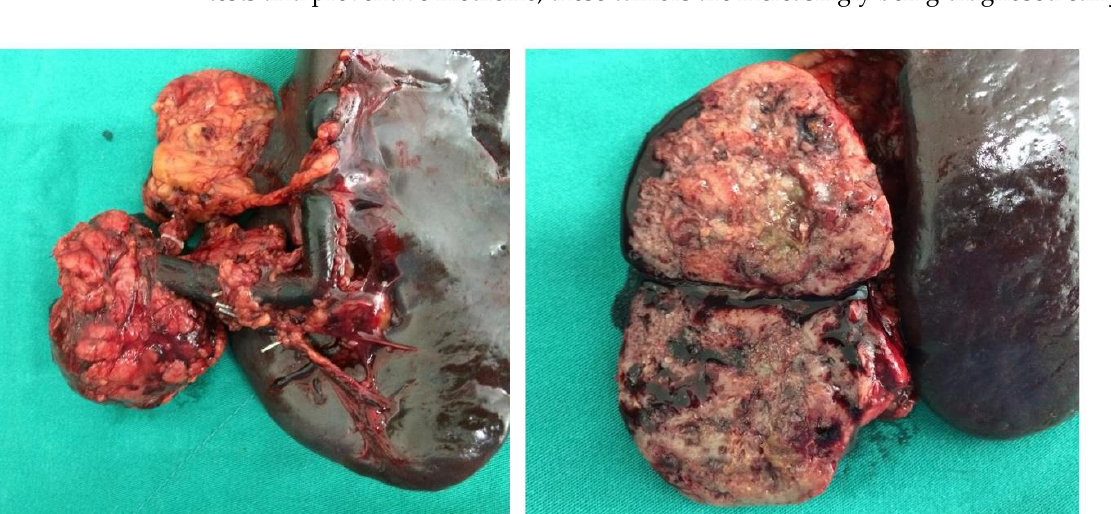
Figure 3. Macroscopic examination of the specimen of one of the reviewed cases, the product of a distal pancreatectomy: solid pseudopapillary neoplasm with areas of necrosis and hemorrhage, well delimited to the pancreatic tail.